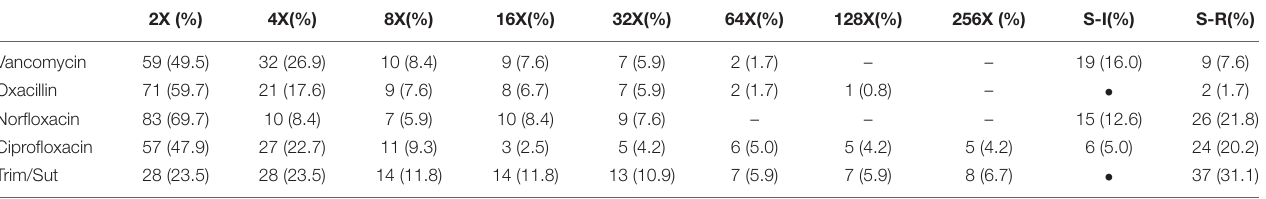
TABLE 2 | Variation of the increase in MIC and change of the category from susceptible to resistant in relation to planktonic cells and in biofilm. 2X (%) 4X(%)